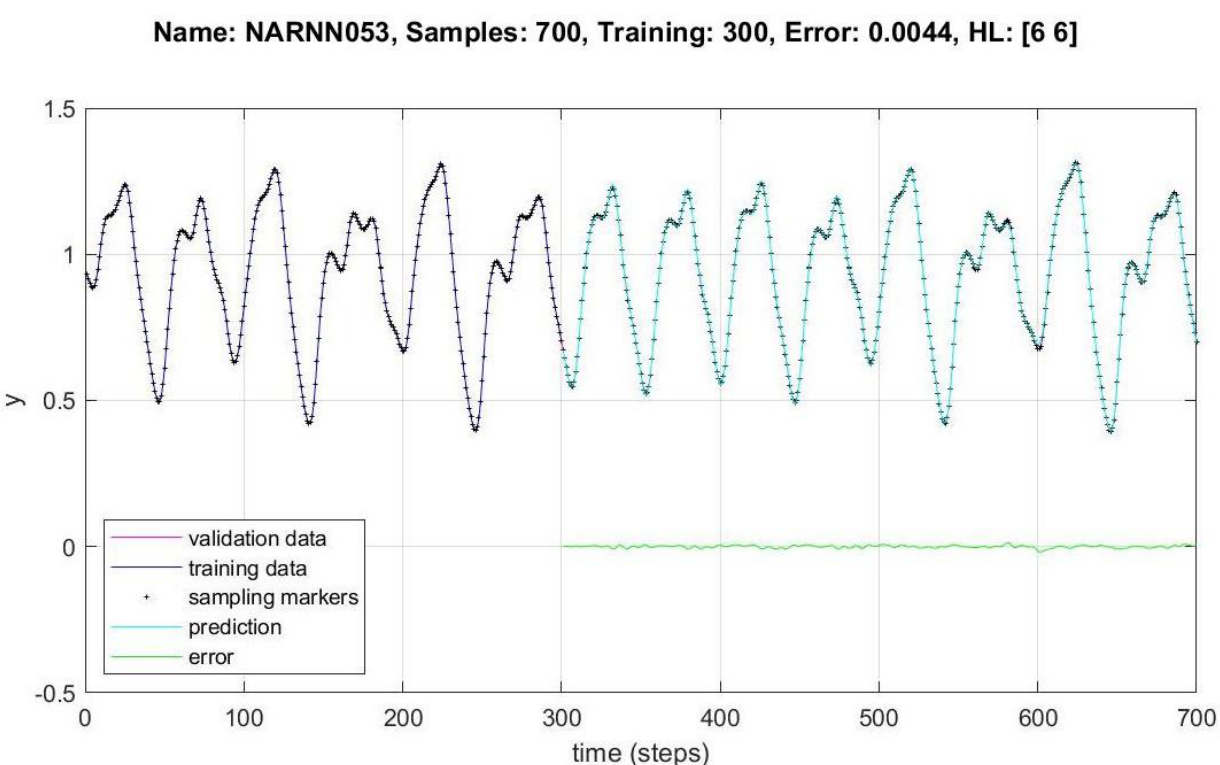
Figure 11. Performance of NARNN053 for 700 samples